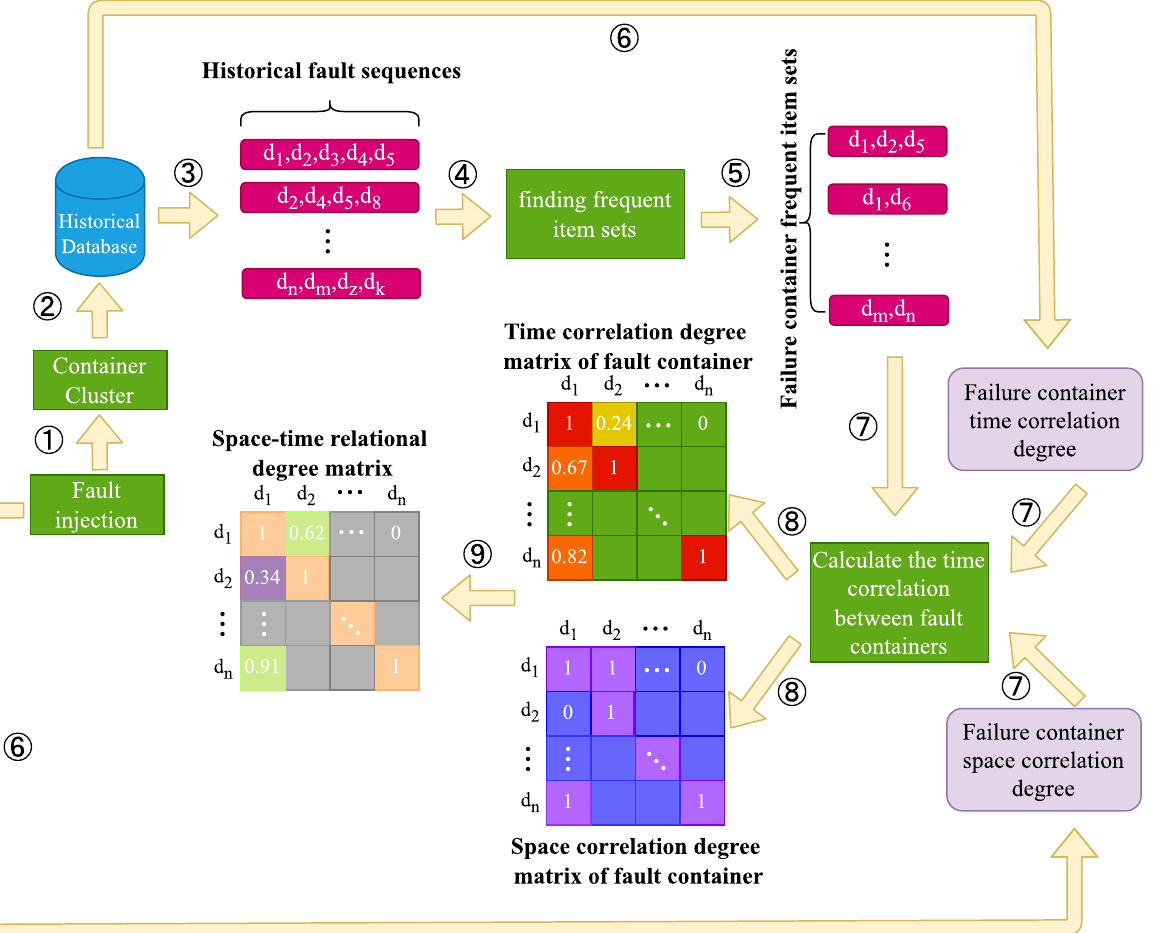
Fig. 2 Fault correlation model construction